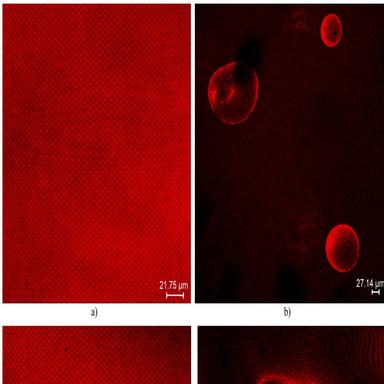
CLSM fluorescence images: a) DGH, b) DGW, c) OGH and d) OGW specimens.